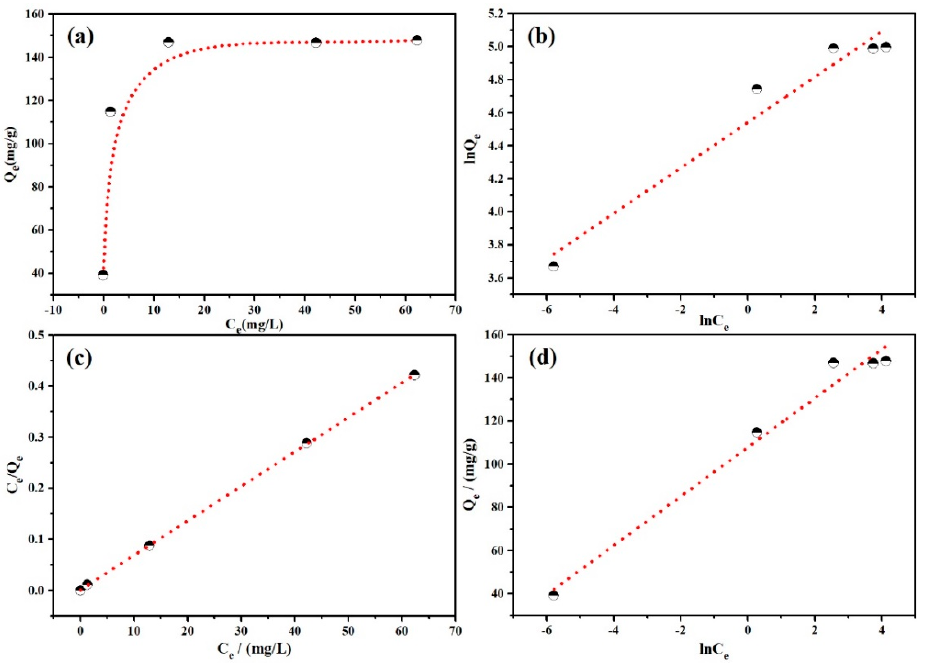
Figure 6. ( a ) Adsorption isotherms for the adsorption of MO by PANI/PSMA at pH 4.0 and 25 °C; ( b ) Freundlich isotherm model plots; ( c ) Langmuir isotherm model plots; ( d ) Temkin model plots. Table 2. Adsorption isotherm parameters for the adsorption of MO onto the PANI/PSMA at pH 4.0 and 25 °C. The contact time was 360 min.